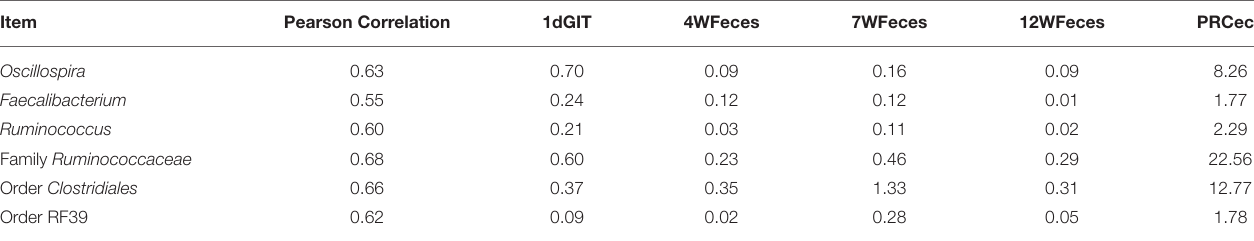
TABLE 2 | Correlations between broiler age and selected bacteria a as well as their respective relative abundances for birds fed the soy-free feed * .